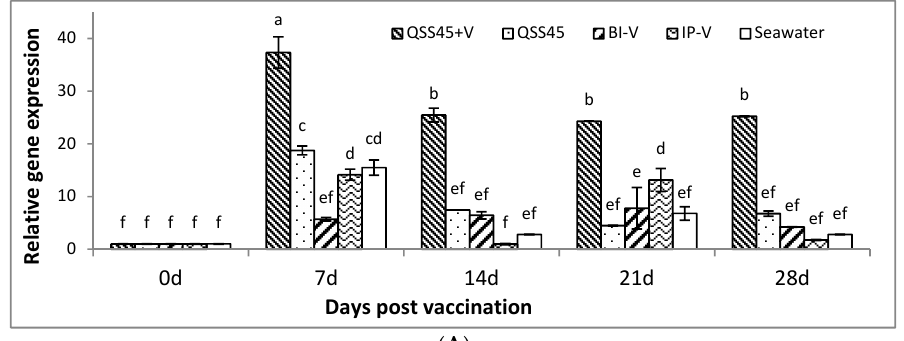
Figure 3. Cont Figure 3. Cont .